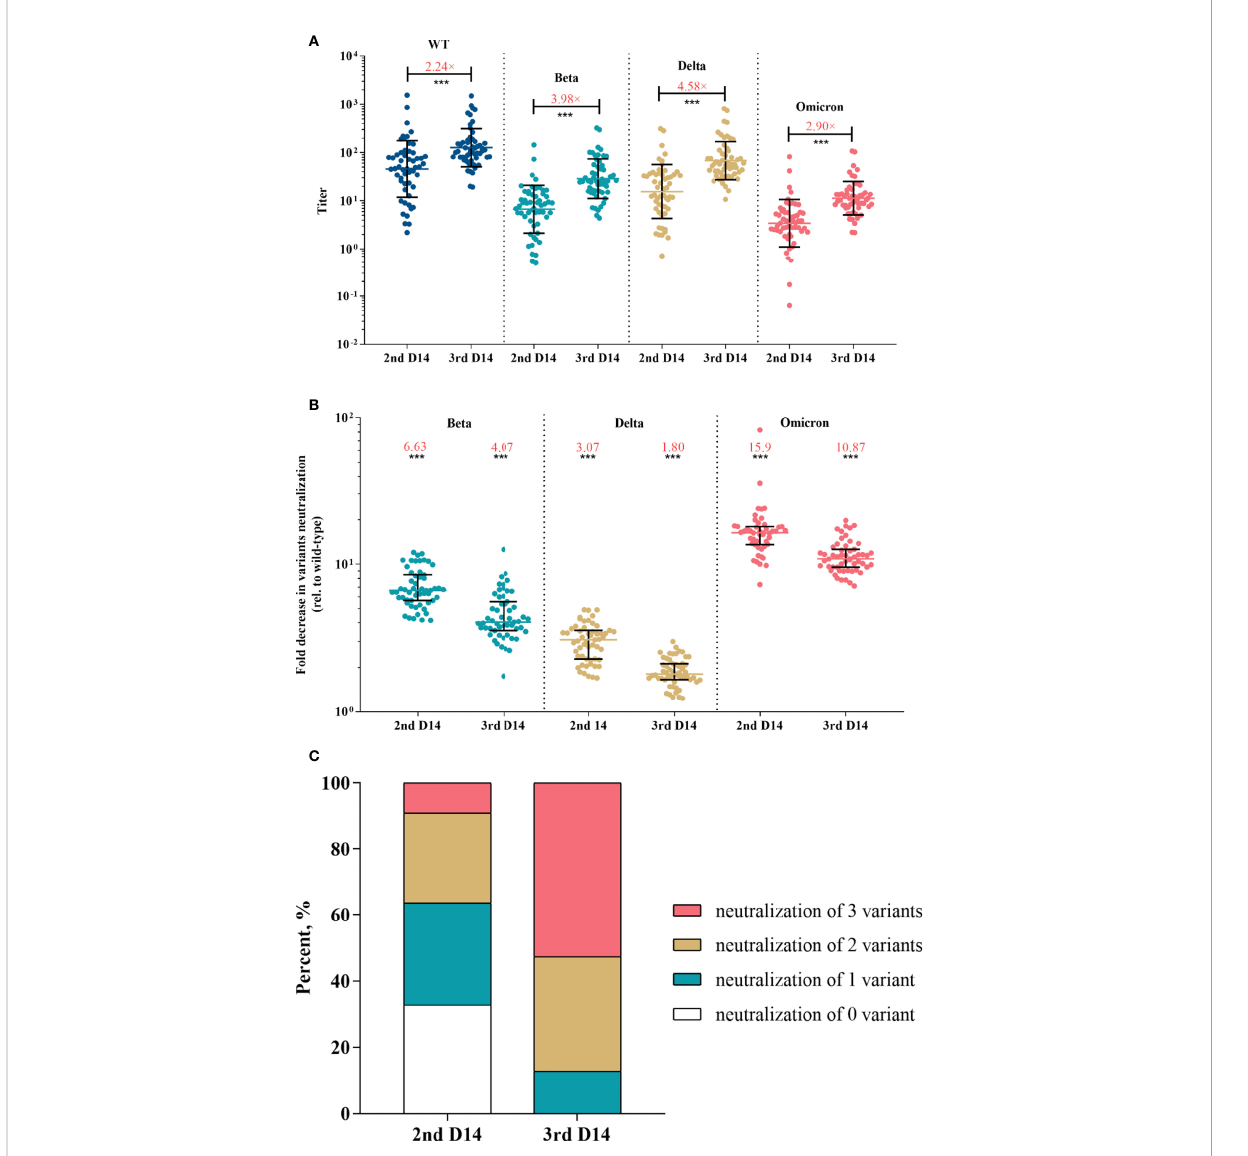
FIGURE 3 Neutralization responses against SARS-CoV-2 and variants in Coronavac recipients post primary and booster vaccinations. (A) Neutralization titers against wild-type and variants of SARS-CoV-2 post primary or booster vaccines; colored bars represent geometric means and black bars represent geometric standard deviations; the median fold-increase in neutralization titer post booster versus primary vaccine is shown as a number with “ × ” symbol in red; ***p<0.001 as compared with day 14 post the second dose. (B) Fold decrease in neutralization for each variant relative to wild-type virus, which was calculated by dividing IC50s titer of the SARS-CoV-2 variant by that of wild-type from the same vaccine sample; colored bars represent medians and black bars represent interquartile ranges; the median fold decrease in each variant neutralization post primary or booster vaccines is shown as a number in red; ***p<0.001 as compared with wild-type. (C) Neutralization breadth of variants elicited by primary and booster vaccination. Statistical comparisons between groups were evaluated by Wilcoxon signed-ranked test. 2nd D14, day 14 post the second dose; 3rd D14, day 14 post the third